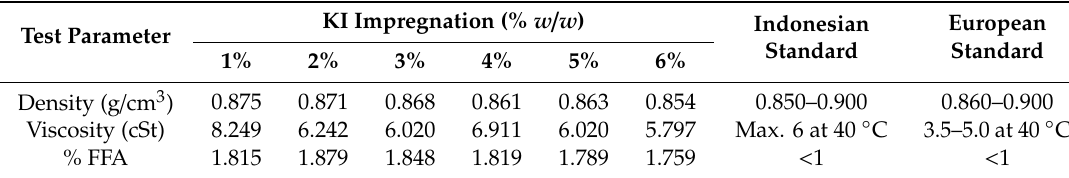
Table 4. Biodiesel characteristic using the HAP / KIO 3